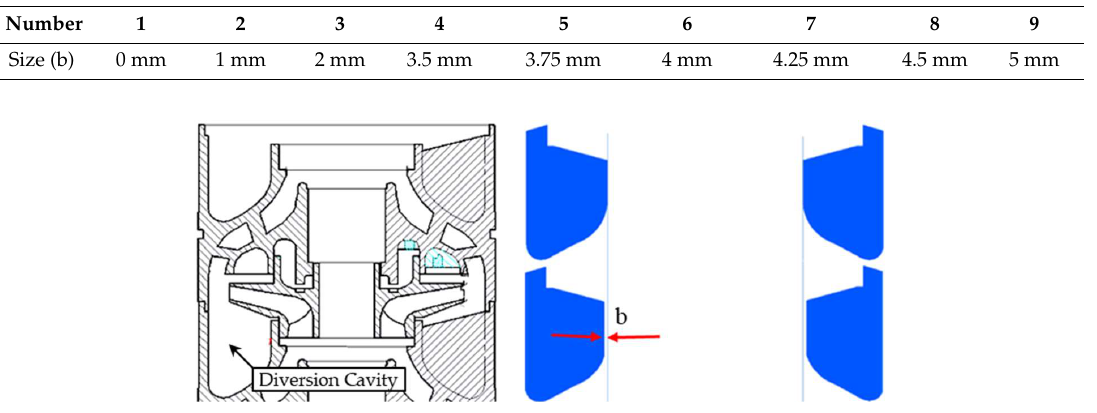
Figure 6. Structure diagram of diversion cavity and optimization schematic diagram. Table 1. Optimization dimension of the diversion cavity.